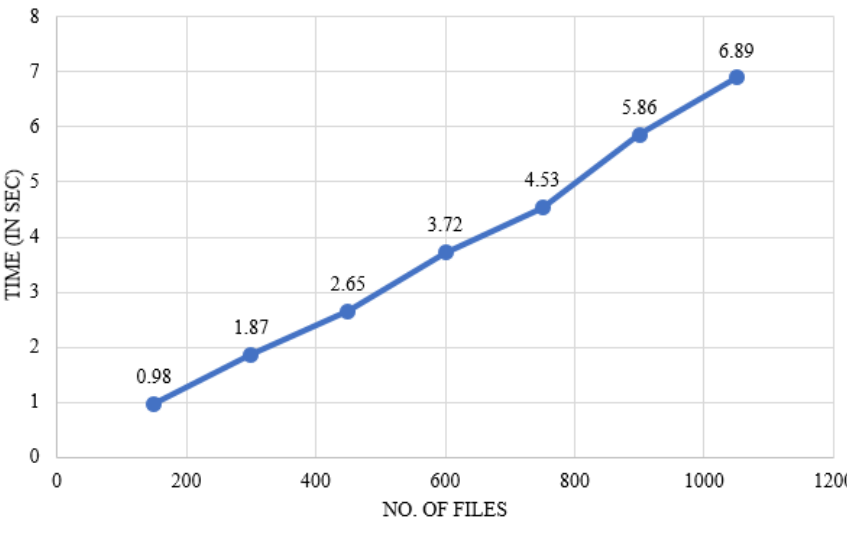
Figure 11. Search Time